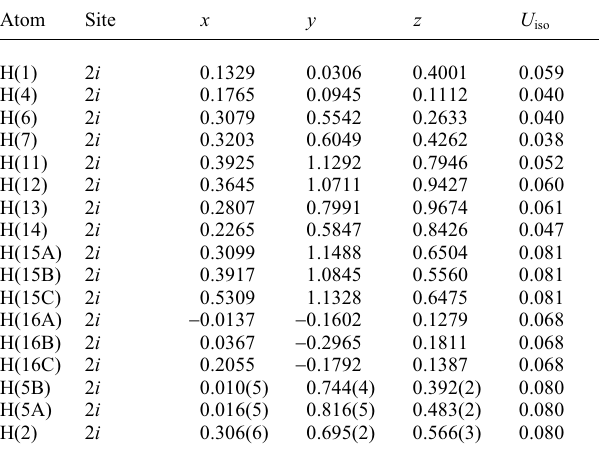
Table 2. Atomic coordinates and displacement parameters (in Å 2 )